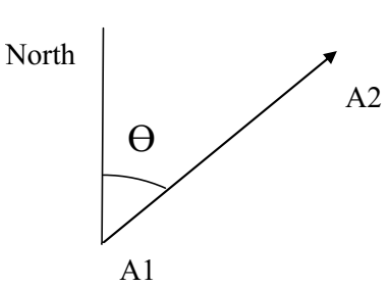
Fig. 7. Azimuth of the ship when